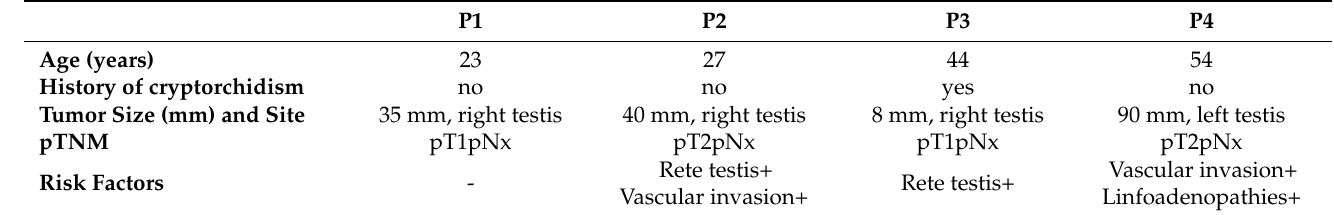
Table 1. Histopathological features of the analyzed samples of human testicular